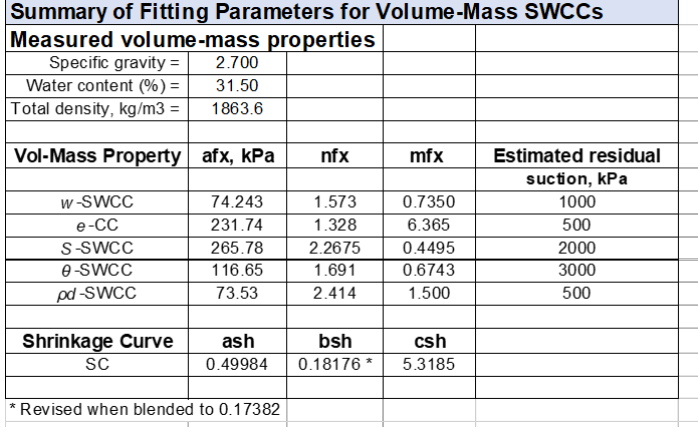
Figure 19. Summary of the fitting parameters for the volume-mass unsaturated soil functions.